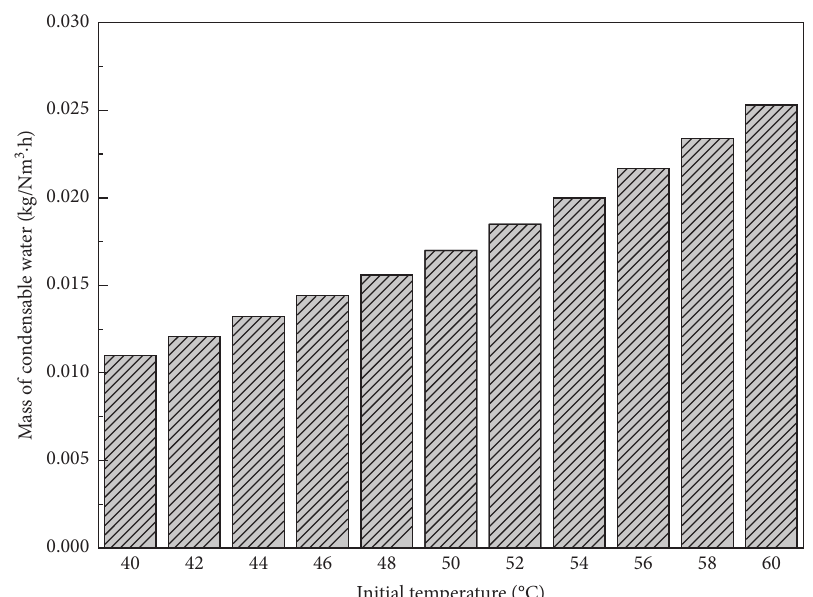
Figure 9: Effect of the initial temperature on the mass of condensable water.